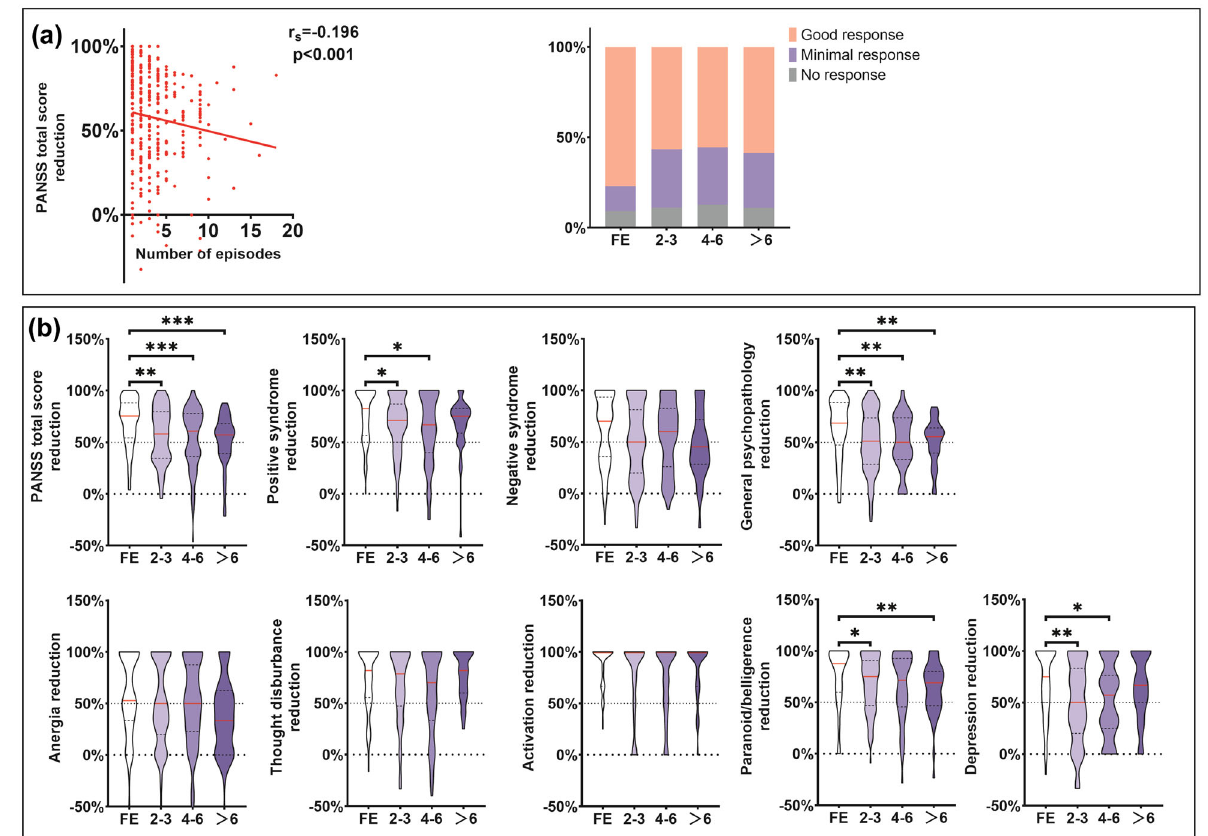
Fig. 1 Symptom improvement after treatment among patients with different episodes. a correlation between PANSS total score reduction and number of episodes; proportion of treatment response in patient subgroups of different episodes. b PANSS reduction after treatment among patients with different episodes. First-episode patients showed the largest improvement in PANSS total scores, positive, general psychopathology, paranoid/belligerence, and depression. No signi fi cant differences were found in negative symptoms or other cluster scores (anergia, thought disturbance, and activation). FE, fi rst episode; Spearman correlation, Kruskal – Wallis test and a Dunn – Bonferroni post hoc method were used; * p < 0.05, ** p < 0.01, *** p <